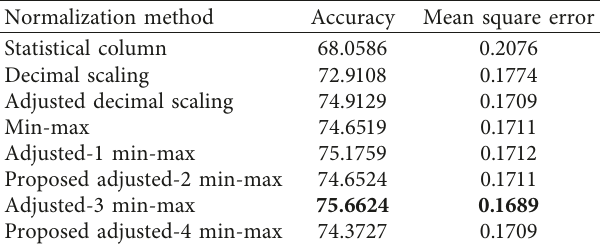
Table 4: Comparative results of prediction efficiency on Pima Indian diabetes dataset yielded by every tested normalization